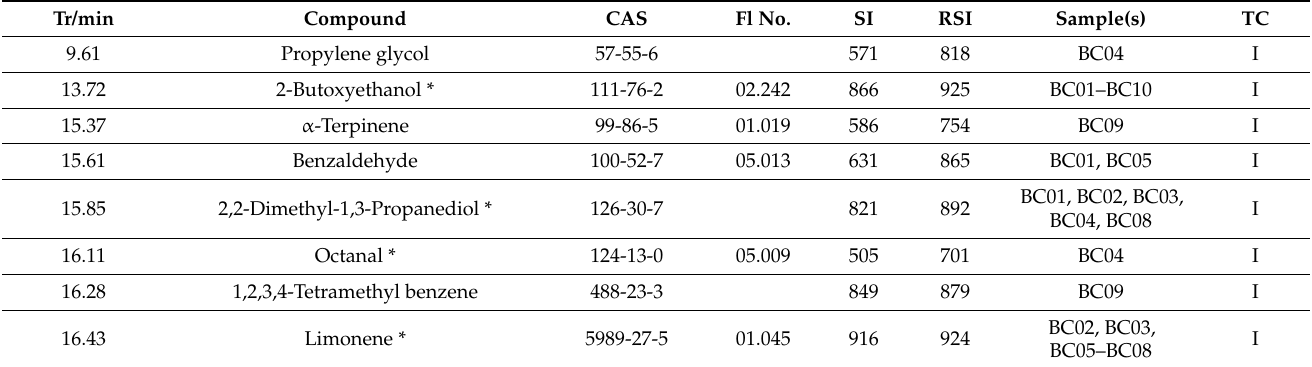
Table 4. Compounds identified via SPME GC-MS analysis.